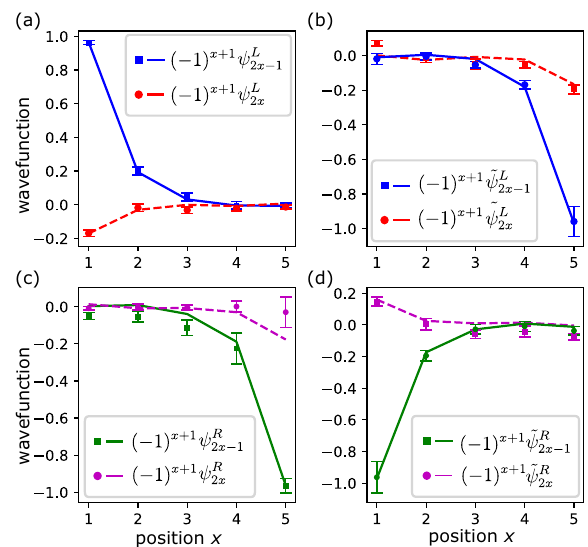
position x Fig.3|Braiding. ComparisonofnormalizedoriginalwavefunctioninEq.(3)forthe left( a )andright( c )modesandbraidedwavefunctioninEq.(10)fortheleft( b )and right ( d ) modes with the theoretically estimated angle α 0 =0.263127 π . We use the 5-qubitsystemon ibm _ hanoi devicewiththeparameters ϕ = π /16, θ = π /4,and φ =0 and maximum number of cycles D =11, averaged over 30 experiments each with 8192 shots. Error bars are one standard of deviation. Experimental data are repre- sented by points, whereas theoretical predictions are represented by lines. Plots illustrate that modes acquire a relative minus sign after braiding ~ ψ L μ = ψ R μ and ~ ψ R μ = (cid:2) ψ L μ